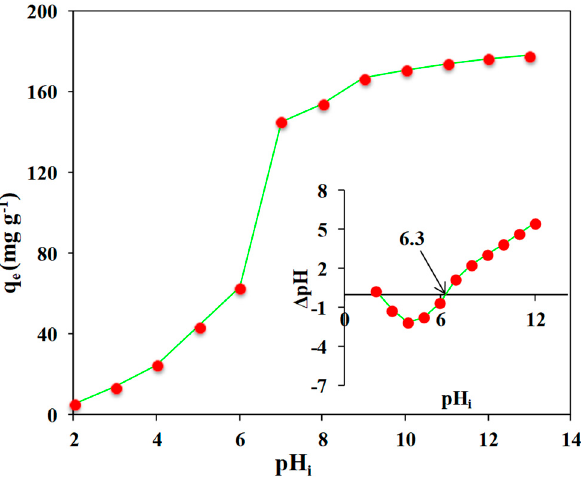
Figure 7. Effect of pH on the adsorption efficiency of CV dye (inset − pH pzc of AISD).